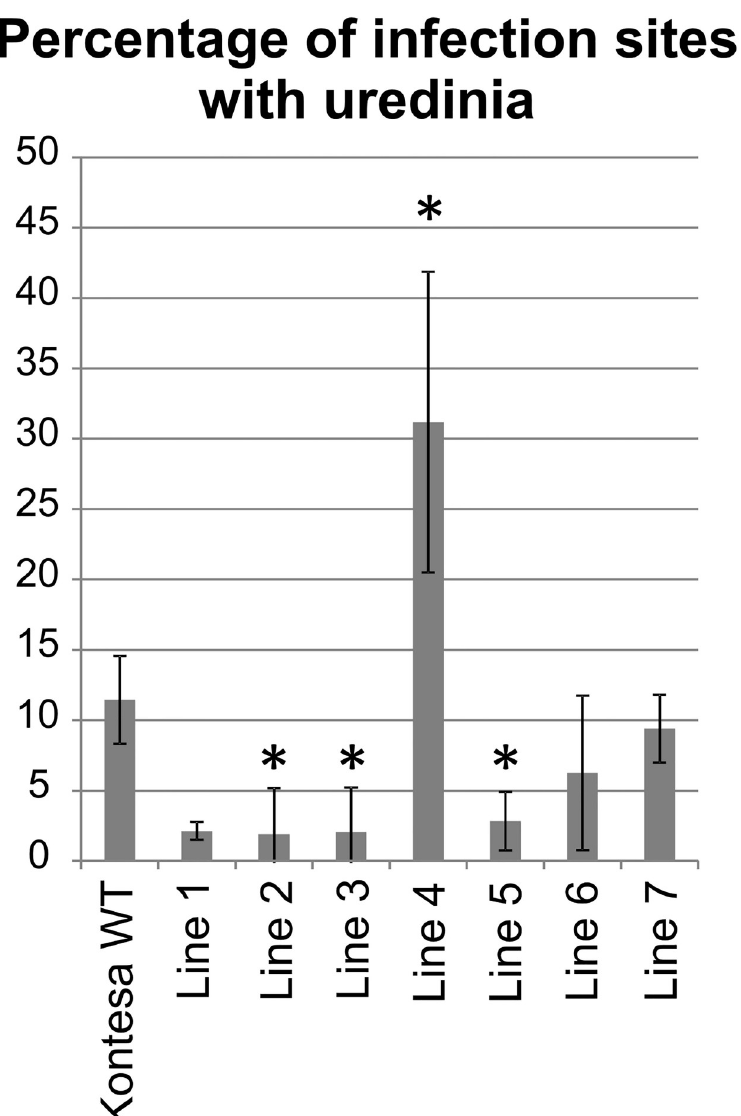
Fig 5. Percentage of infection sites with uredinia scored on flag leaves of non-transgenic Kontesa and 7 transgenic lines overexpressing TaWAK6 gene 16 days post inoculation with P . triticina . Data represent mean values with standard errors of the mean; asterisk indicates p < 0.05 using the ANOVA test followed by LSD post-hoc test (STATISTICA 10, StatSoft).